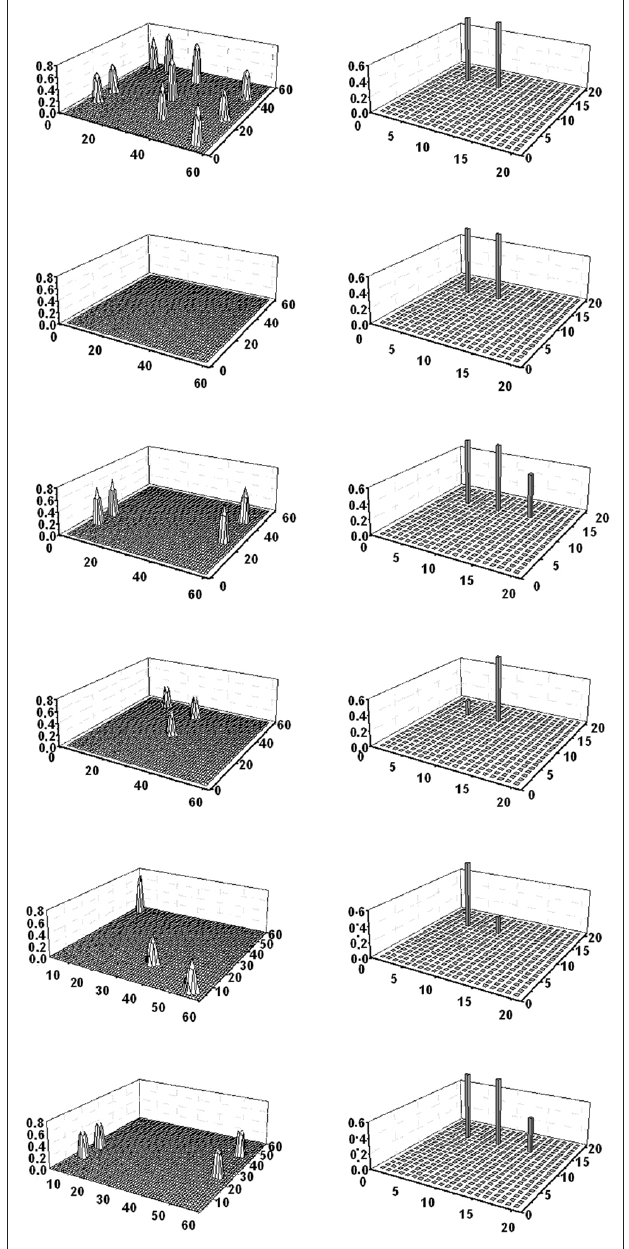
Figure 6 | Simulation of an object recognition task in which the subject must recognize two members of the same category. All 10 properties of dog and cat (four shared properties and three distinctive properties for each object) are given to the semantic network. The six lines represent activity in the semantic network (left panels) and in the lexical network (right panels) at steps 11, 133, 176, 239, 285, and 347 of the simulation (duration of each step: 0.2 ms). As the figure shows, the conceptual representations of the two objects are correctly reconstructed in the semantic network, and the corresponding words (“dog” and “cat”) evoked in the lexical network, despite the presence of four shared features (see the second, fourth, and sixth lines). The word designating the category (“pet”) does not appear in the lexical network. It is worth noting that some isolated features appear at some instants during the simulation (third and fifth lines), but do not evoke any response in the lexical area.